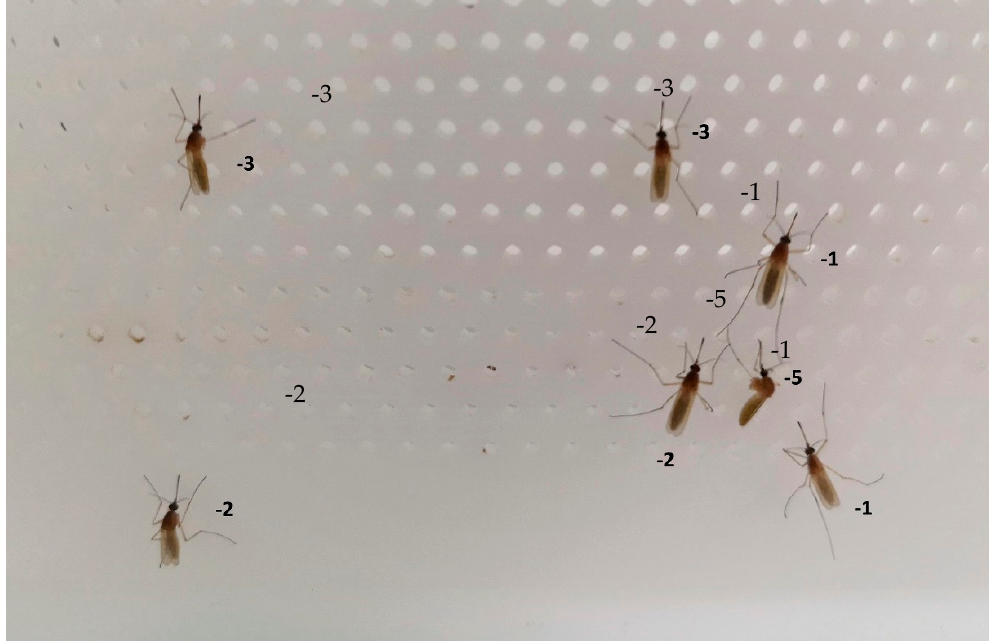
Figure 3. Photograph showing a sample of female Cx. pipiens that lost legs following prallethrin exposure. The numbers next to the mosquitoes indicate the number of legs lost.